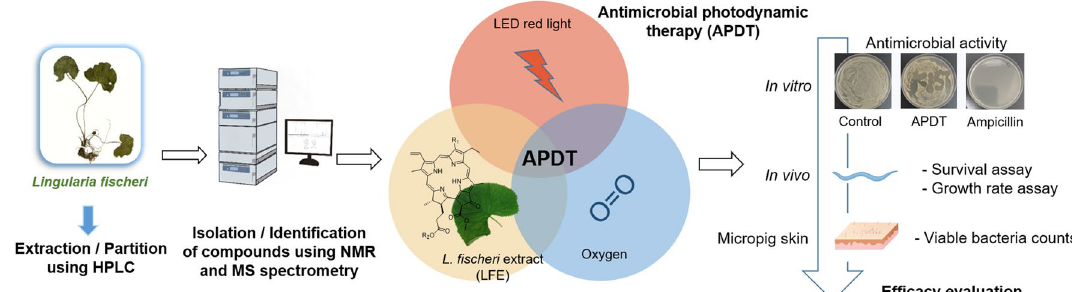
Fig. 1 Experimental scheme of the present study, antimicrobial photodynamic therapy (APDT) with Ligularia fischeri extract